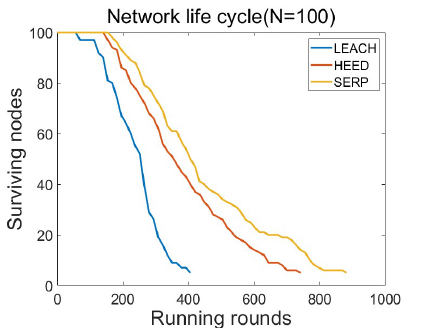
Figure 7. Network life cycle when the number of nodes N = 100.